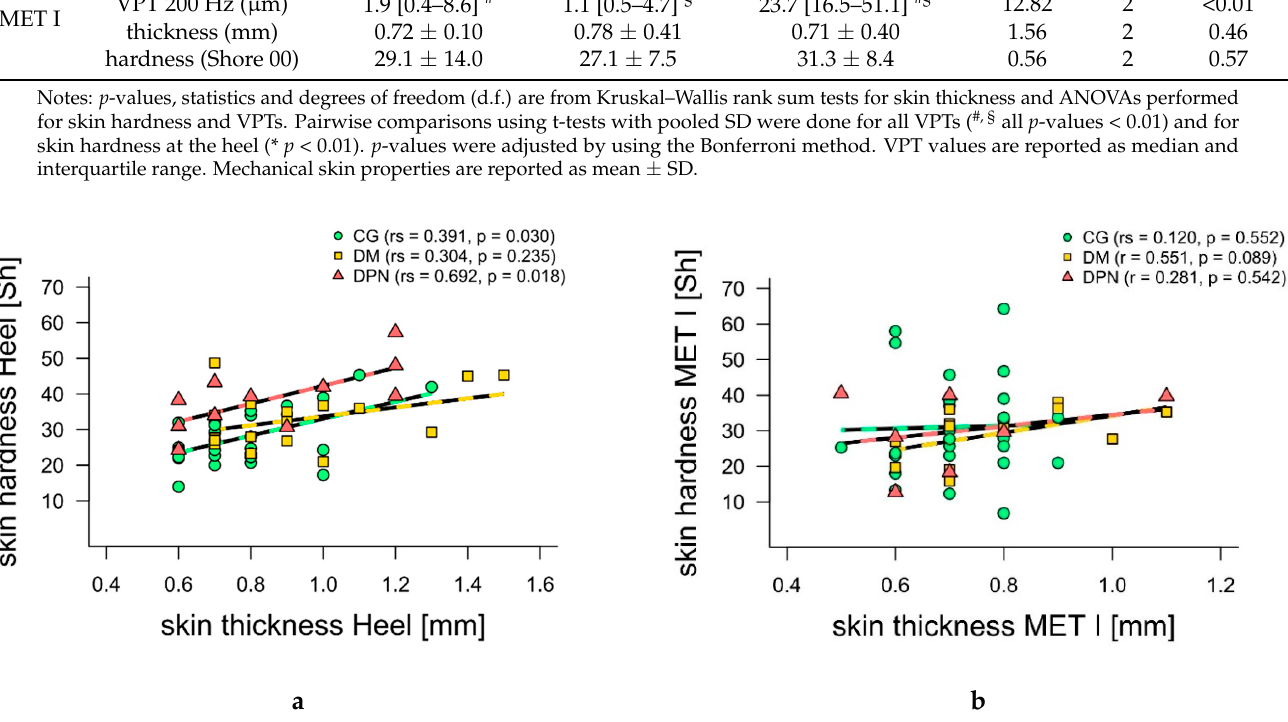
Figure 2. Spearman’s rank-order (rs) and Pearson’s product-moment (r) correlations between skin hardness and skin thickness separated by groups. ( a ) Scatter plot of skin hardness versus skin thickness at first metatarsal head (MET I) for control group (CG, green), individuals with diabetes without diabetic neuropathy (DM, yellow) and individuals with diabetes with diabetic neuropathy (DPN, red). ( b ) Scatter plot of skin hardness versus skin thickness at heel for control group (CG, blue), individuals with diabetes without diabetic neuropathy (DM, yellow) and individuals with diabetes with diabetic neuropathy (DPN, red).